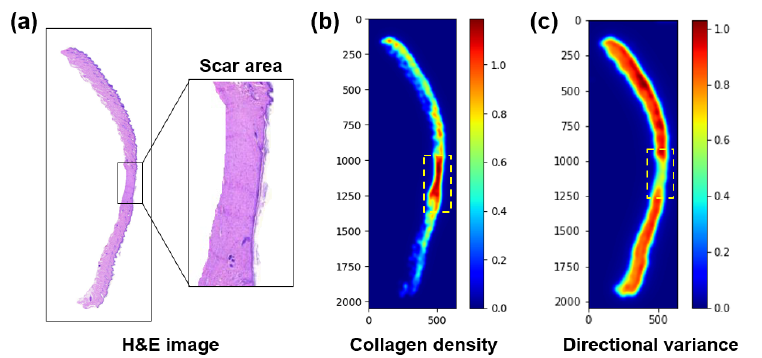
Figure 6. Tissue characterization from whole histology slide image: ( a ) HE-stained tissue (dermis area), ( b ) corresponding collagen density map (CDM), and ( c ) directional variance map. Yellow dashed lines represent the corresponding scar